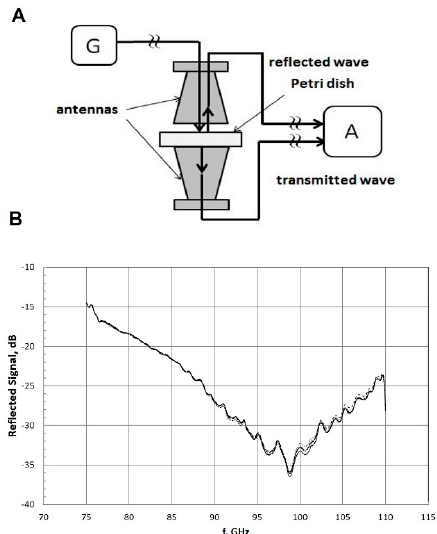
Figure 1. Illustration of the irradiation setup ( A ). G represents the millimeter wave generator and A represents the network signal analyzer. The scalar network analyzer measured the waves reflected partly into the upper antenna and transmitted partly into the lower antenna. Characterization of the dielectric properties of petri dishes ( B ). The graph represents the frequency spectra of the reflected signal of five empty Petri dishes (Nunc TM , Thermo Fisher Scientific ). In total, 43 dishes were tested with the same results.